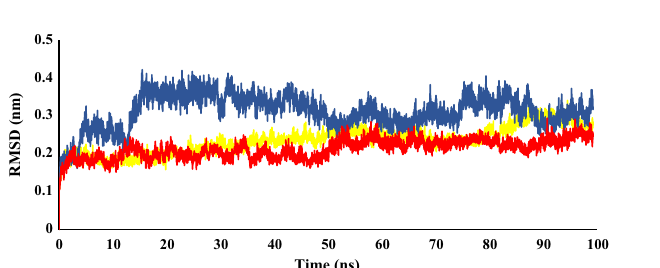
Figure 7. Molecular docking analysis of the interaction of selected synthesized derivatives with c-Met receptor kinase domain. Interactions and binding modes of compounds 6e ( A ), 6h ( B ) and 6k ( C ) are shown. Van der Waals, hydrogen bond, and pi–alkyl interactions were colored as light green, bold green and light pink, respectively. Also, pi–anion, pi–sulfur and pi–pi interactions were colored as dark orange, light orange and dark pink respectively. ( D ) Comparison of binding mode of selected compounds 6e (blue), 6h (purple) and 6k (orange) with the crystallographic ligand foretinib (red) is shown in the active site of c-Met. Images were created by Discovery Studio Client v12.2.0.16349.